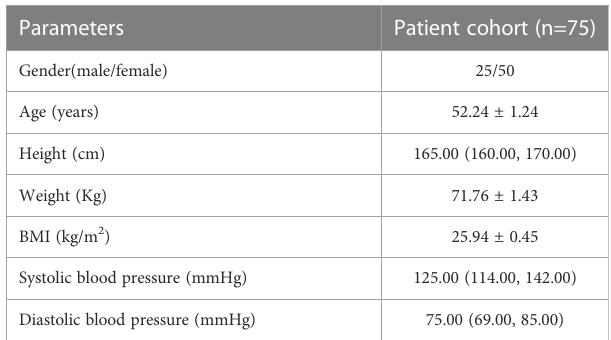
TABLE 1 Baseline characteristics of patients with DTC who were scheduled to receive radioactive iodine therapy following